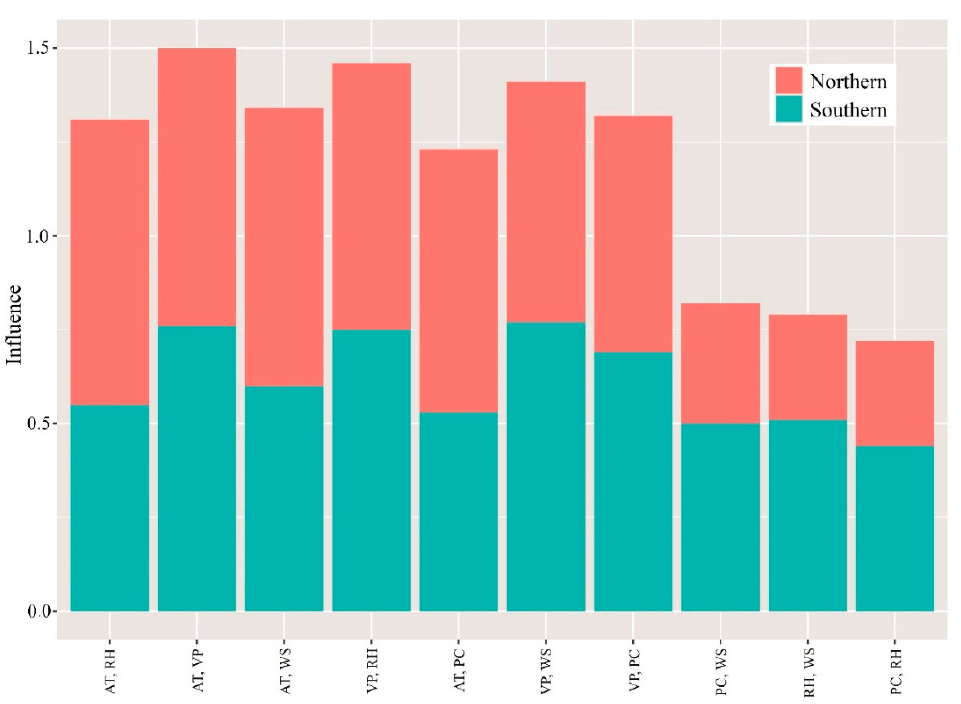
Figure 7. Interactions among socioeconomic factors in Northern and Southern China. Note: PD: population density, UR: the non ‐ agricultural proportion of the population, PG: per capita gross do ‐ mestic product, IO: industrial output, PS: proportion of secondary industry.